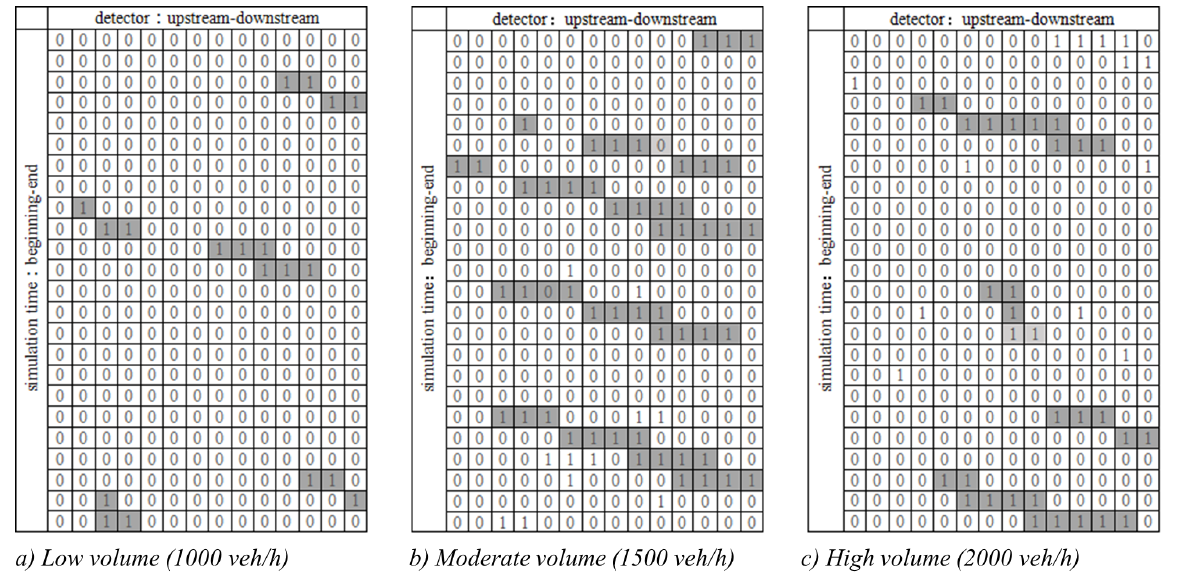
Fig 10. Space-time diagram under different traffic condition with no violations.